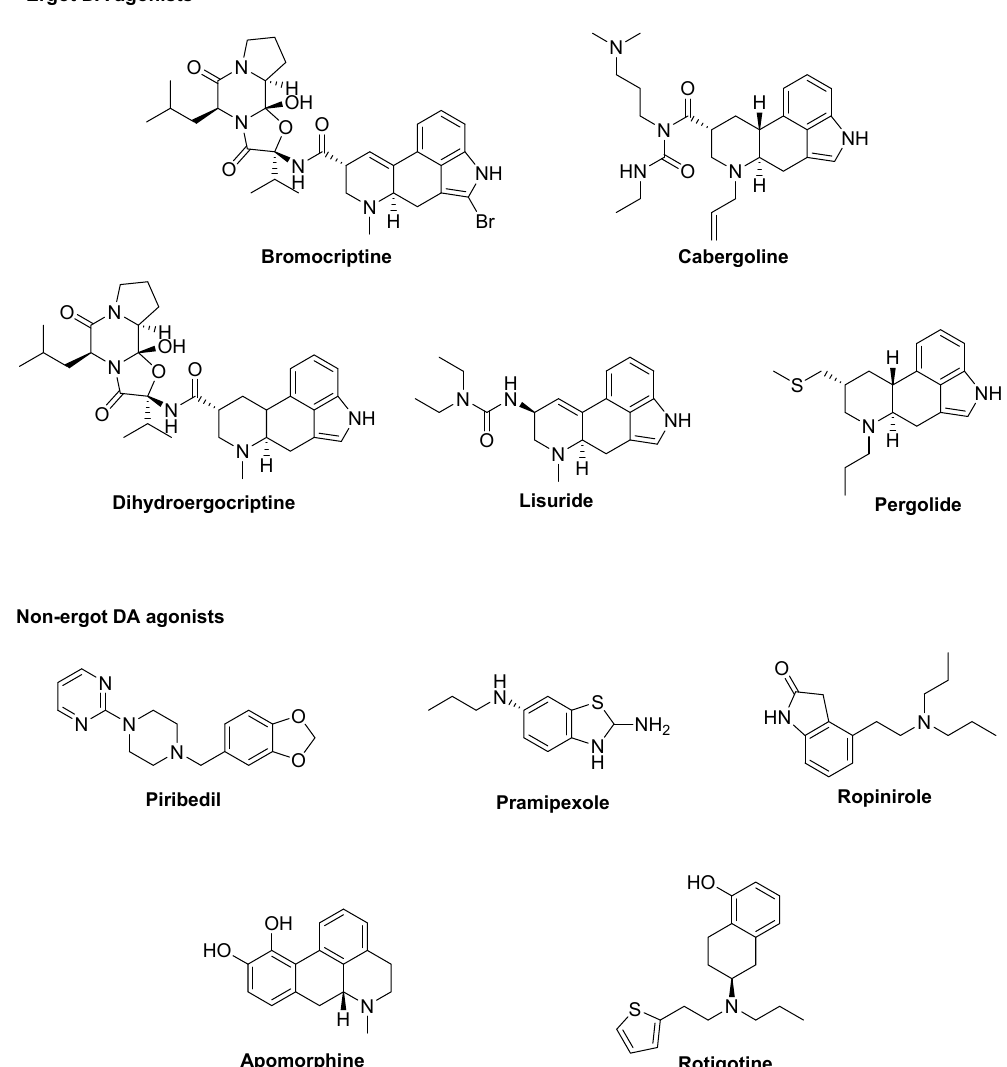
Figure 1 . Dopamine (DA) agonists available for Parkinson’s disease (PD) treatment. Figure 1. Dopamine (DA) agonists available for Parkinson’s disease (PD)